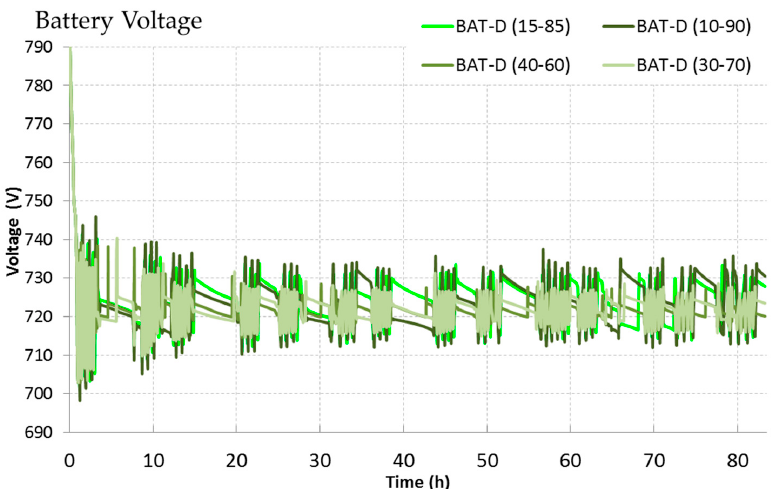
Figure 23. BAT energy store voltage, depending on the selected configuration of powertrain: BAT-D (15–85), BAT-D (10–90), BAT-D (30–70), BAT-D (40–60).